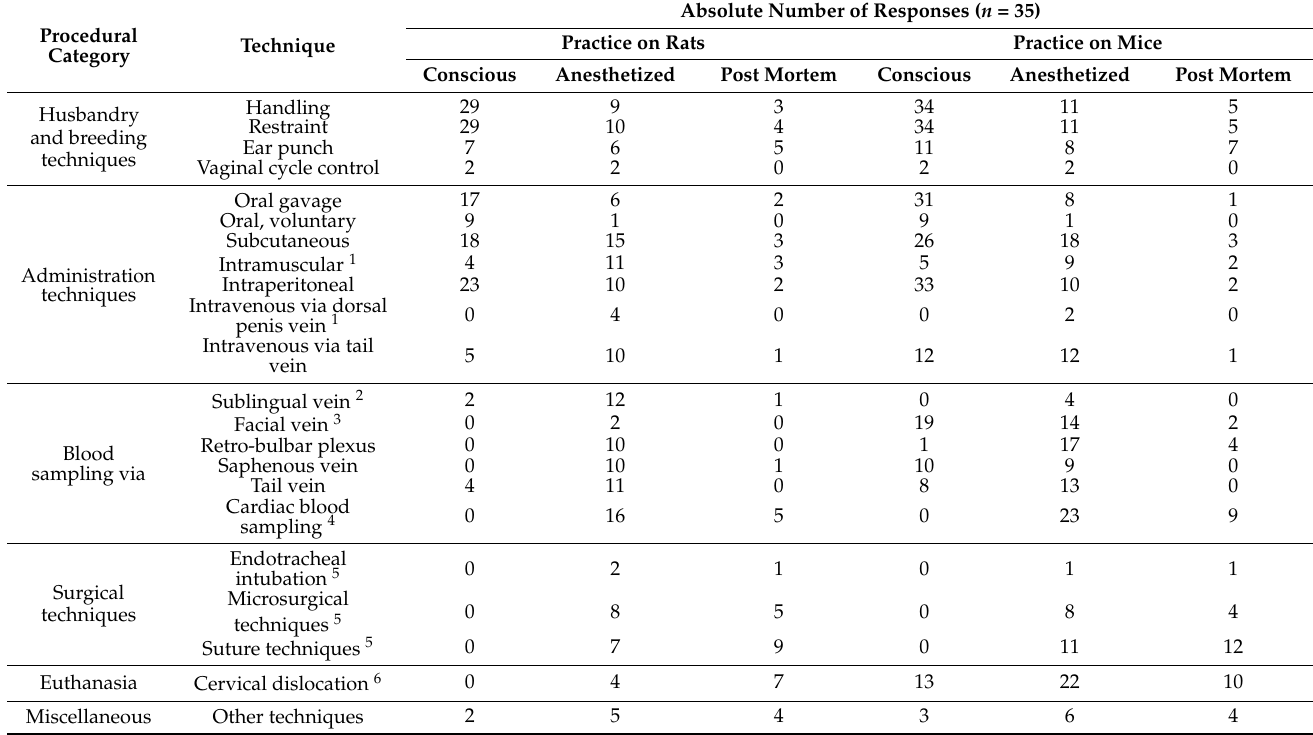
Table 2. Descriptive analysis of techniques trained on live animals in Laboratory Animal Science Courses. Distribution of replies concerning techniques practiced on conscious or anesthetized rats and/or mice or post mortem in the most frequently performed course type derived from the multiple choice question “Which techniques do you train on animals in the practical course part? Please indicate whether training is done on conscious or anesthetized rat or mouse or post mortem”. Absolute number of responses are shown for each technique and species with regard to its condition ( n =